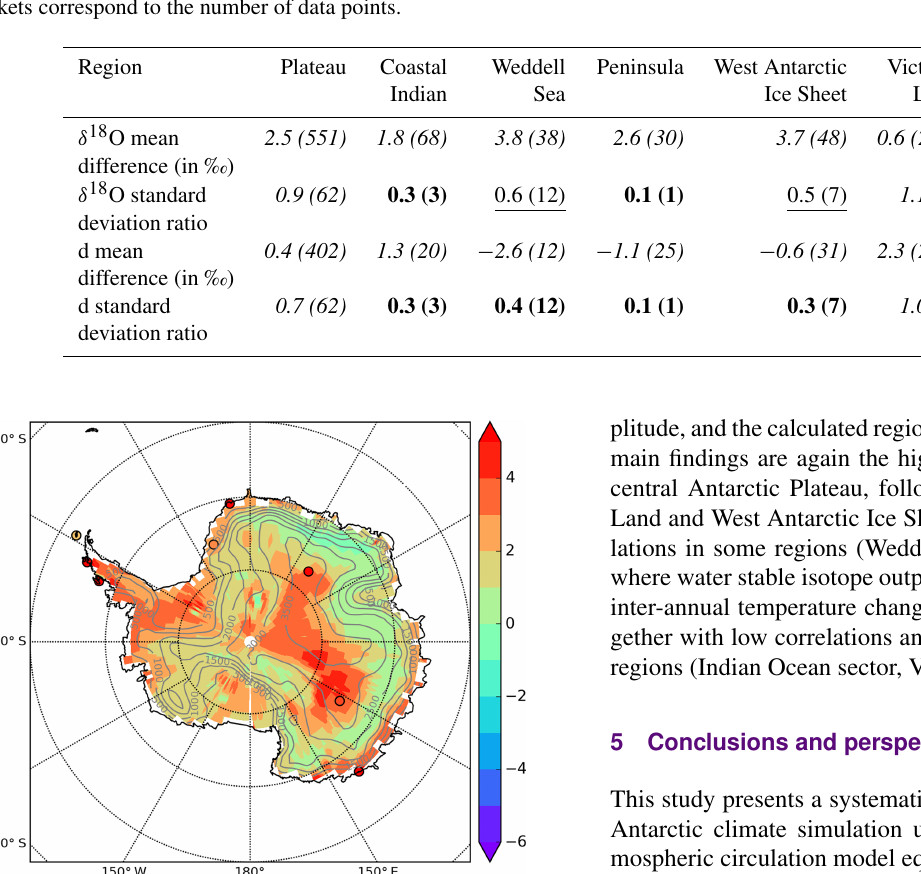
Table 9. Evaluation of the ECHAM5-wiso model for seven Antarctic regions: East Antarctic Plateau, coastal Indian, Weddell Sea, peninsula, West Antarctic Ice Sheet, Victoria Land, and Dronning Maud Land (7). We regionally averaged the time-averaged δ 18 O mean (model–data) differences (in ‰), the inter-annual δ 18 O standard deviation (model / data) ratio, the time-averaged d mean (model–data) differences (in ‰), and the inter-annual d (model–data) standard deviation ratio using only precipitation data. Italic cells correspond to parameters for which we support the validity of the use of ECHAM5-wiso for the considered region, underlined cells to parameters for which we suggest some caution, and bold cells to parameters for which we suggest not using ECHAM5-wiso outputs for the considered region. The numbers in brackets correspond to the number of data points.